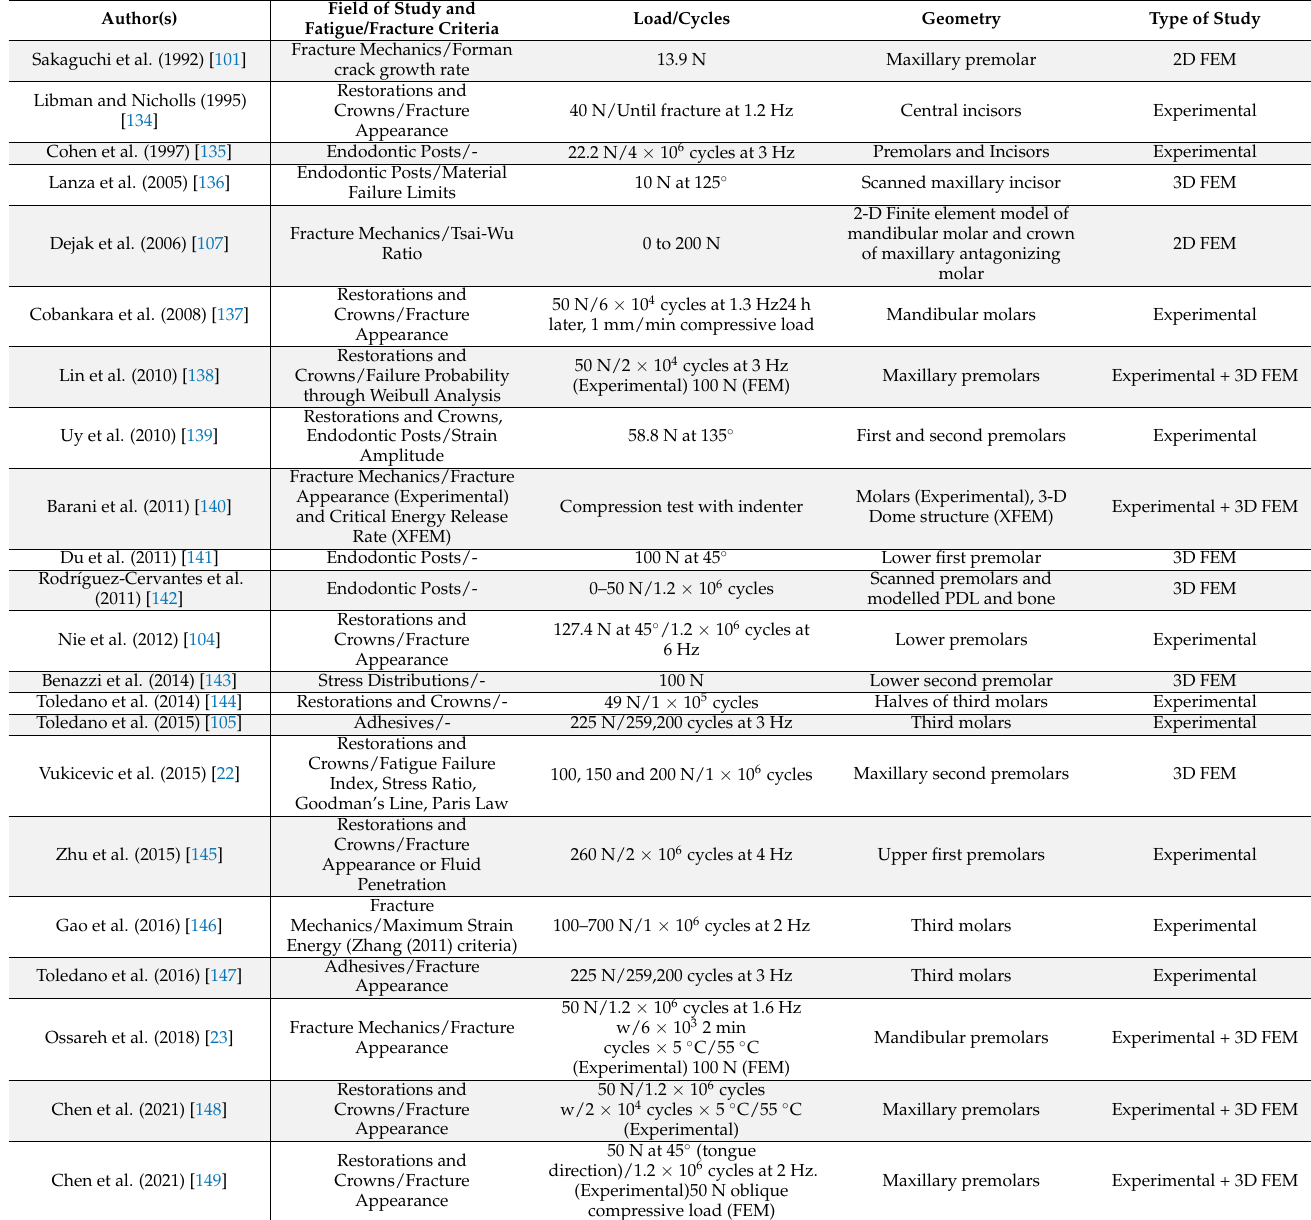
Table 6. Summary of experimental and FEM studies on biting